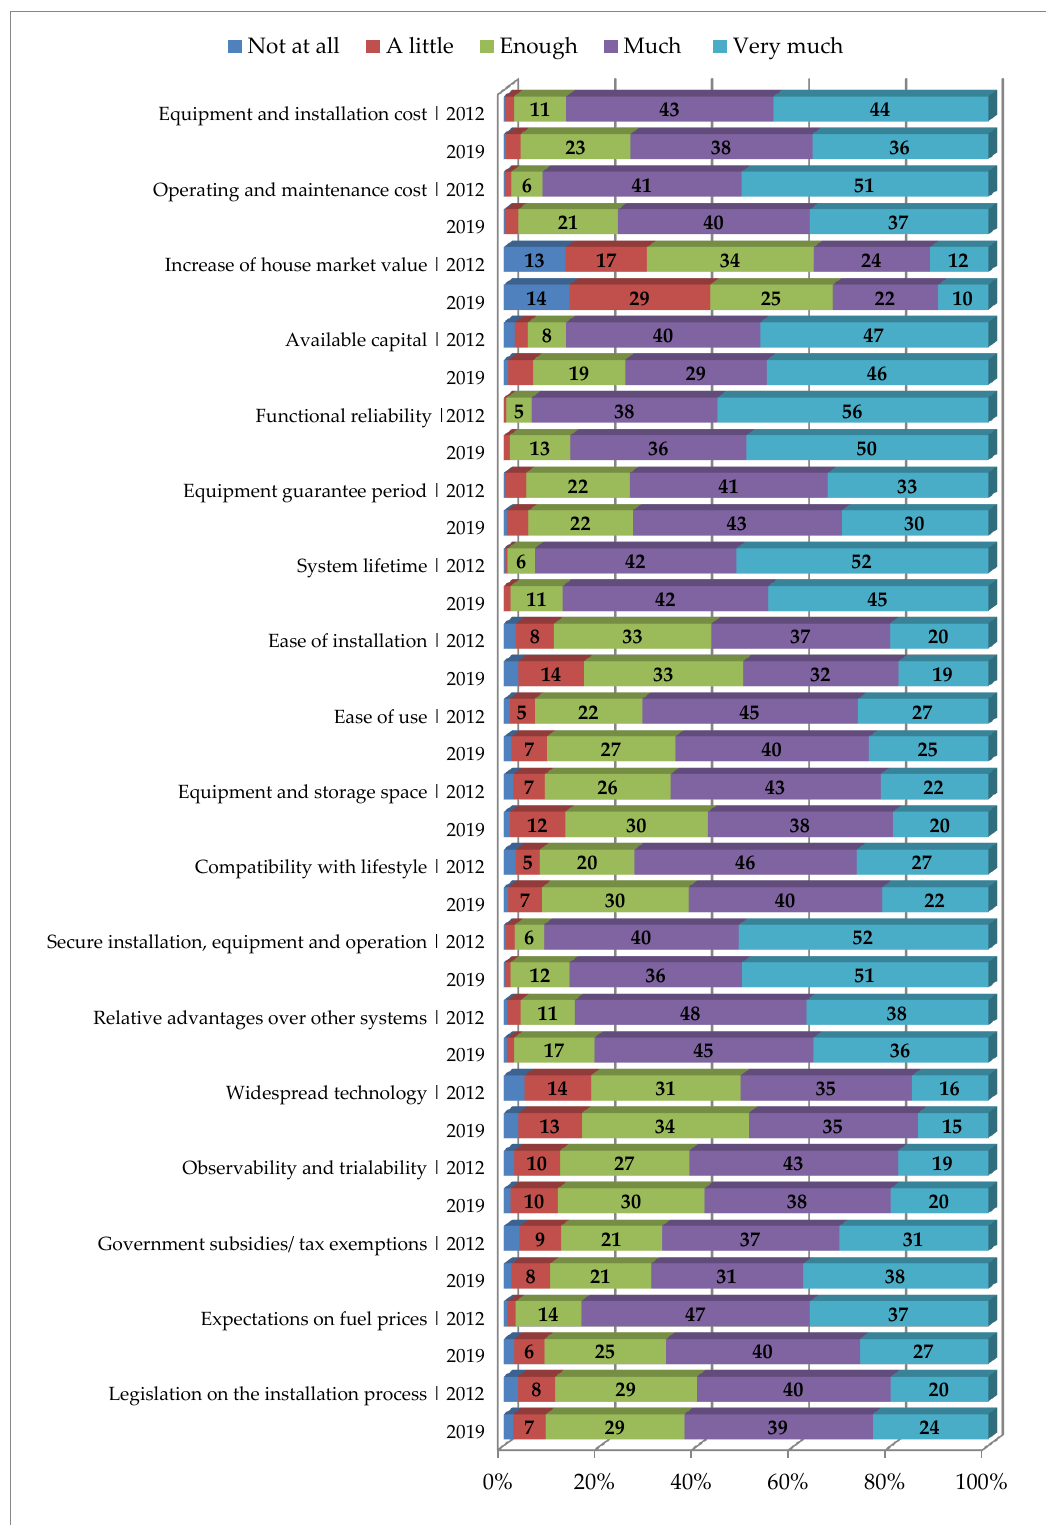
Figure 1. Perceived importance of factors related to consumers’ behavior, preferences and attitudes for residential microgeneration technologies.